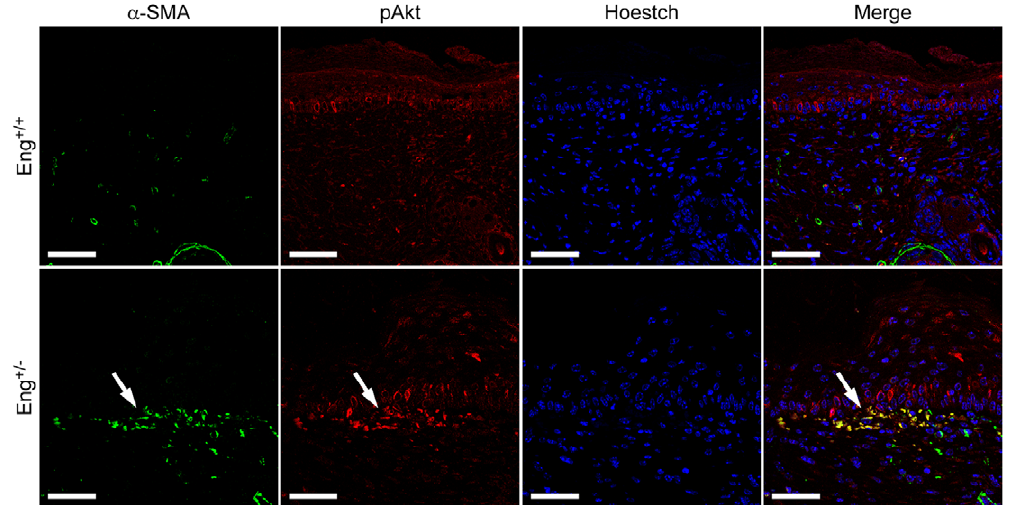
Figure 9. Histological analysis of Akt phosphorylation after wound healing. Immunofluorescence staining of alpha-smooth muscle actin ( a - SMA) and phospho-Akt (pAkt) on Formalin-fixed Parafin-embedded wounds from Eng + / + and Eng + / 2 mice at day 12. Bars=50 mm. Arrow=Colocalization of a -SMA and pAkt. A representative image from four independent experiments is shown.